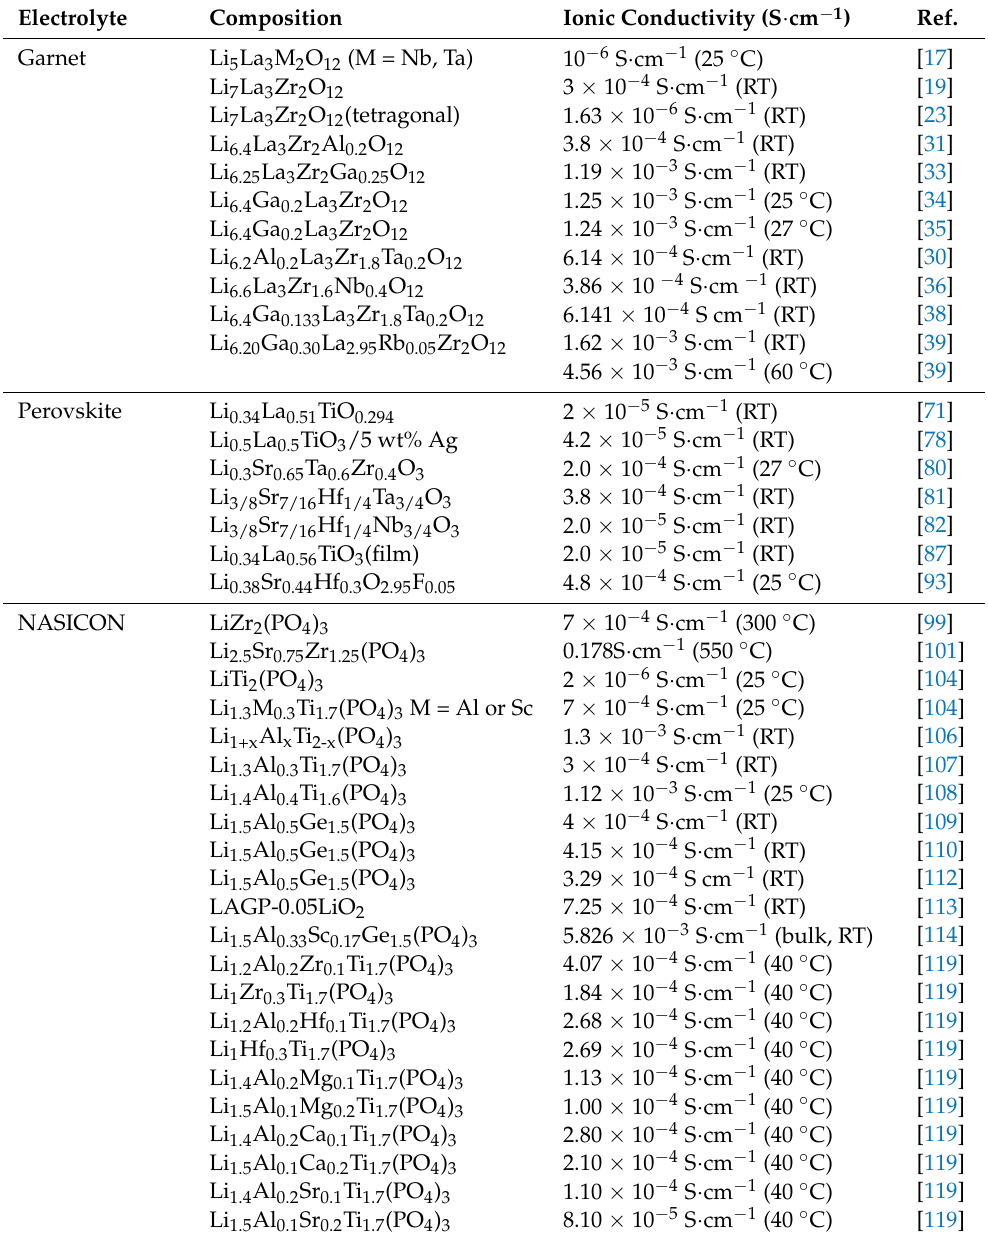
Table 1. Summary of ionic conductivity of solid electrolytes. Electrolyte Composition Ionic Conductivity (S · cm − 1 ) Ref.